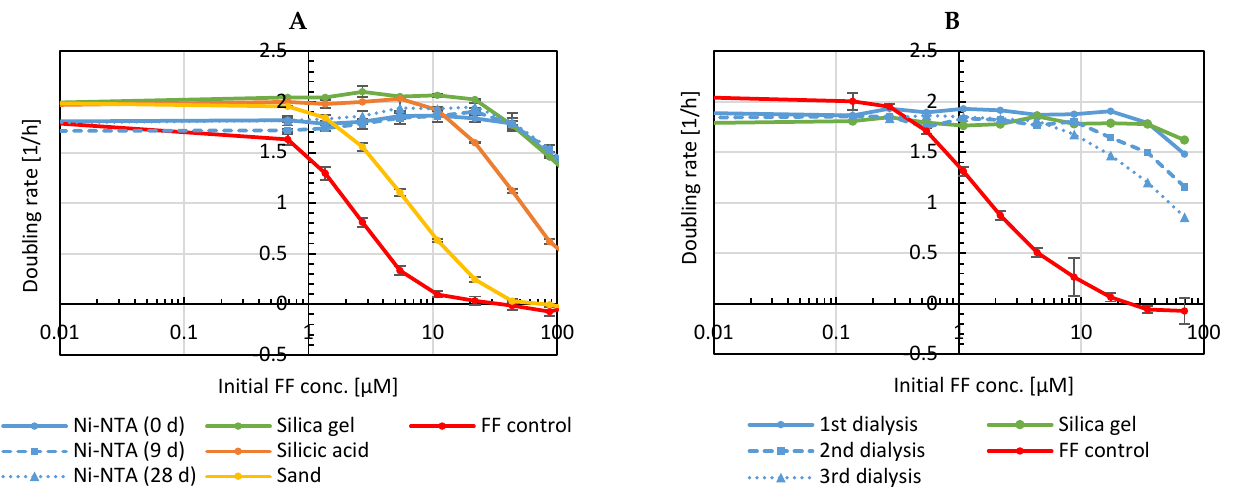
Figure 7. Comparison of florfenicol inactivation in salt solutions. ( A ) Growth assay of BL21 after overnight incubation of FF-containing DYT with immobilized hydrolase 36P5. ( n = 4 (all Ni-NTA, FF control); n = 2 (silica gel 60, silicic acid, sand), time in days for Ni-NTA describes the storage and repeated use); ( B ) Growth test of BL21 after overnight incubation of FF-containing saltwater with hydrolase encapsulated with a semi-permeable membrane after first, second or third use (1st dialysis, 2nd dialysis, 3rd dialysis) or immobilized to silica material ( n = 4 (FF control), n = 1 (dialysis; Silica)).